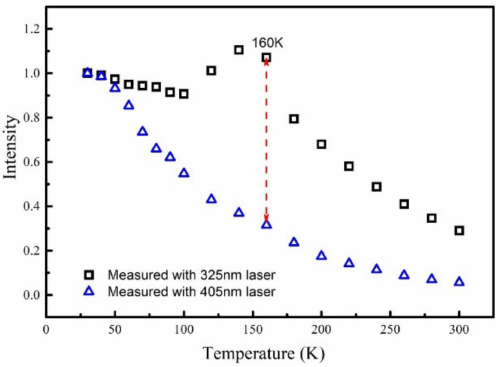
Figure 4. The comparison of the normalized integrated PL intensity measured with a 325 nm laser and a 405 nm laser for sample